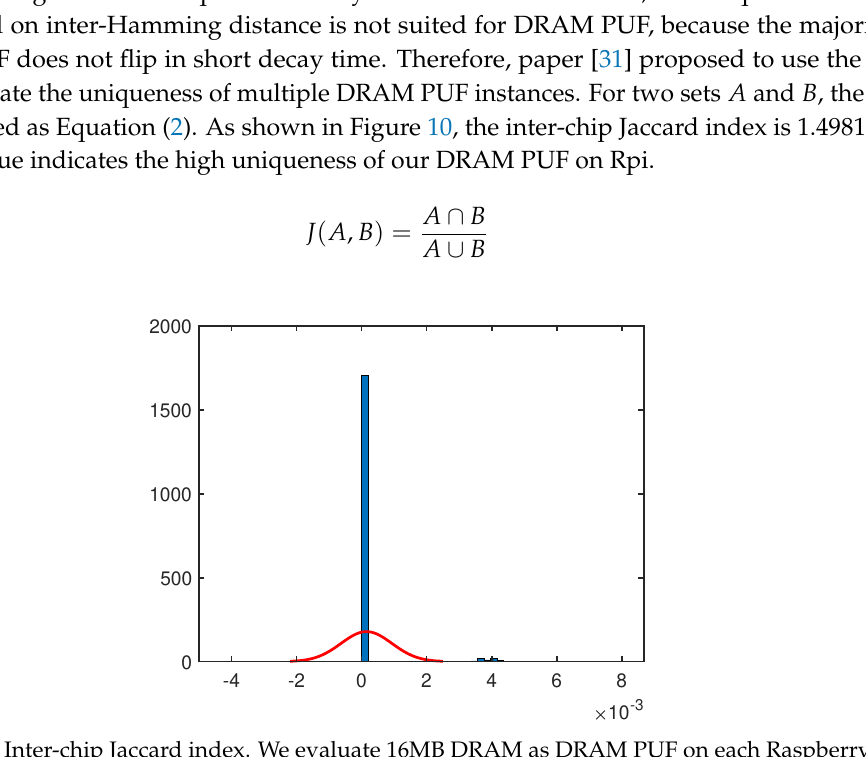
Figure 10. Inter-chip Jaccard index. We evaluate 16MB DRAM as DRAM PUF on each Raspberry Pi board. Given that we do not have enough boards to evaluate the inter-chip Jaccard index, we